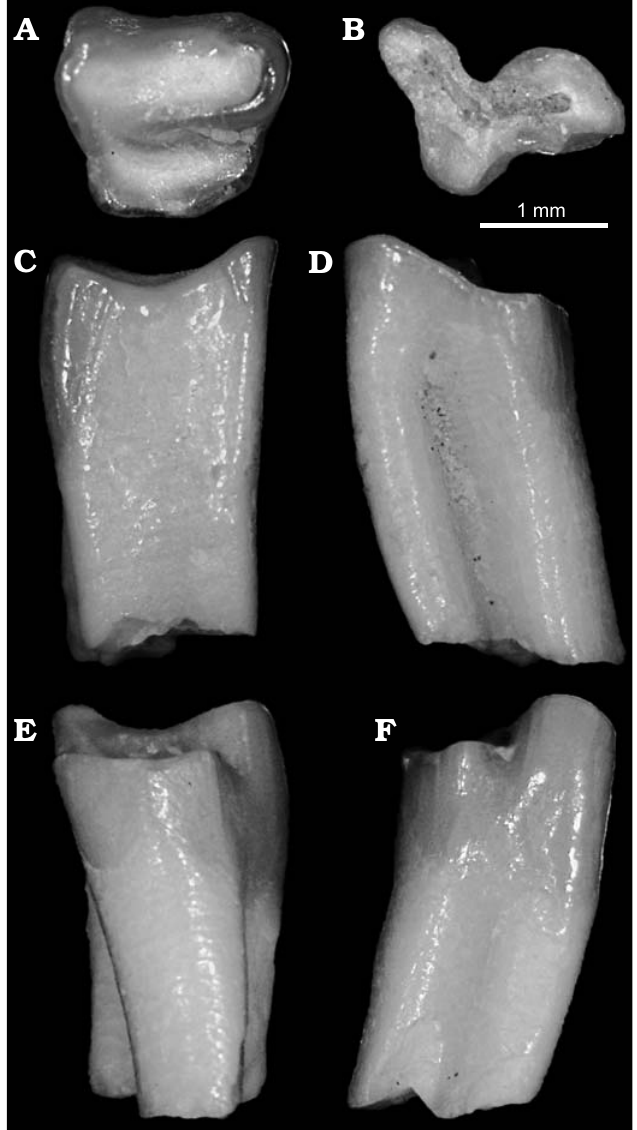
Fig. 6. Lagomorph Erenlagus anielae Fostowicz-Frelik and Li, 2014 from the Eocene of Wulanhuxiu, Nei Mongol, China. Right m2 (IVPP V20258) in occlusal ( A ), apical ( B ), mesial ( C ), lingual ( D ), distal ( E ), and buccal ( F ) views.